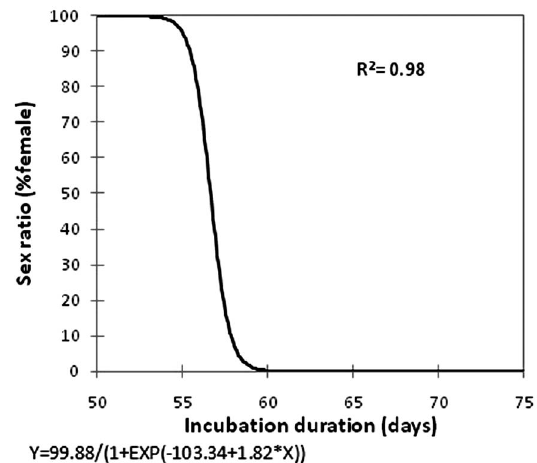
Fig . 3. – Percentage of females as a function of incubation duration (Derived from Mrosovsky et al. (2002) and adapted to the